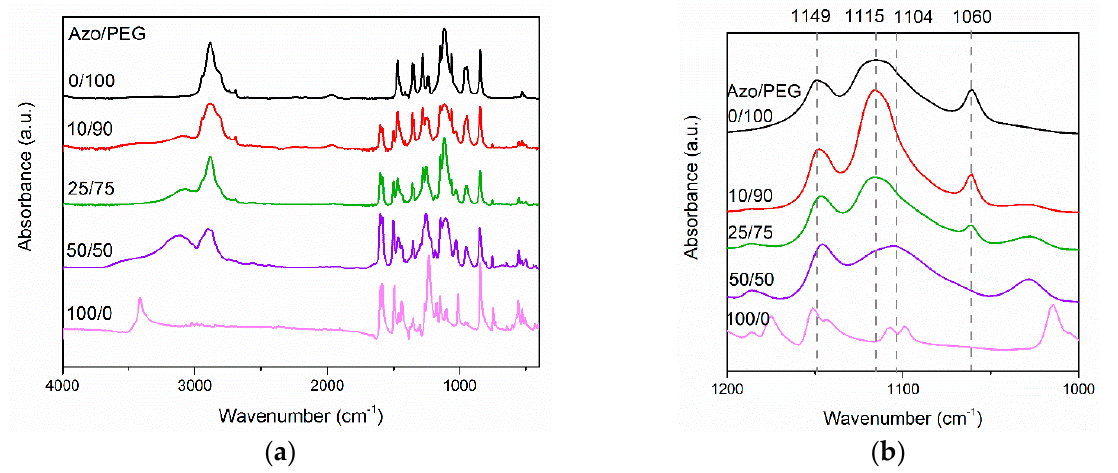
Figure 2. Fourier transform infrared (FTIR) of Azo/PEG complexes at wavenumbers of ( a ) 4000–400 cm − 1 and ( b ) 1200–1000 cm − 1 . The complex compositions are designated in wt %.